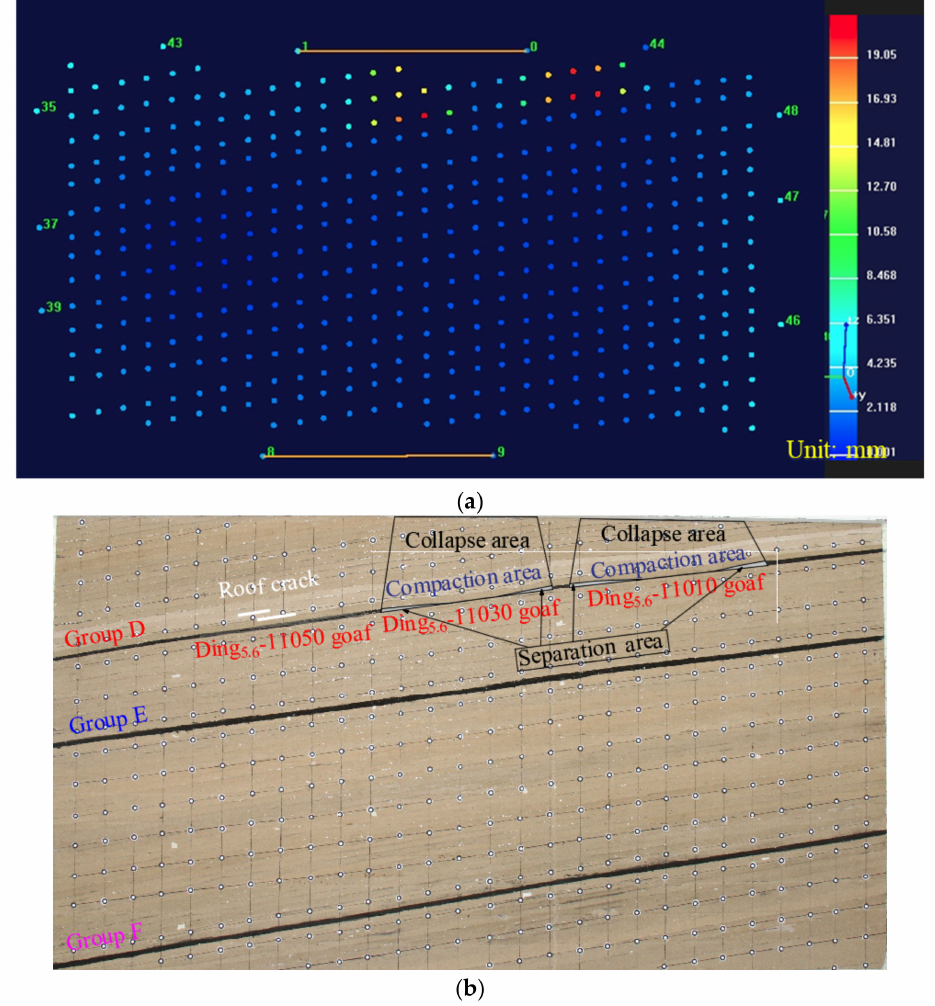
Figure 4. Drawing of roof caving and displacement in mining of Group D coal seam: ( a ) Displacement vector diagram at the end of mining in the Group D working face; ( b ) Overburden collapse at the end of the Group D